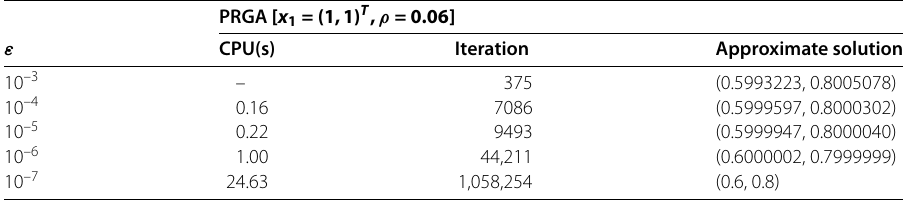
Table 4 Numerical results for Example